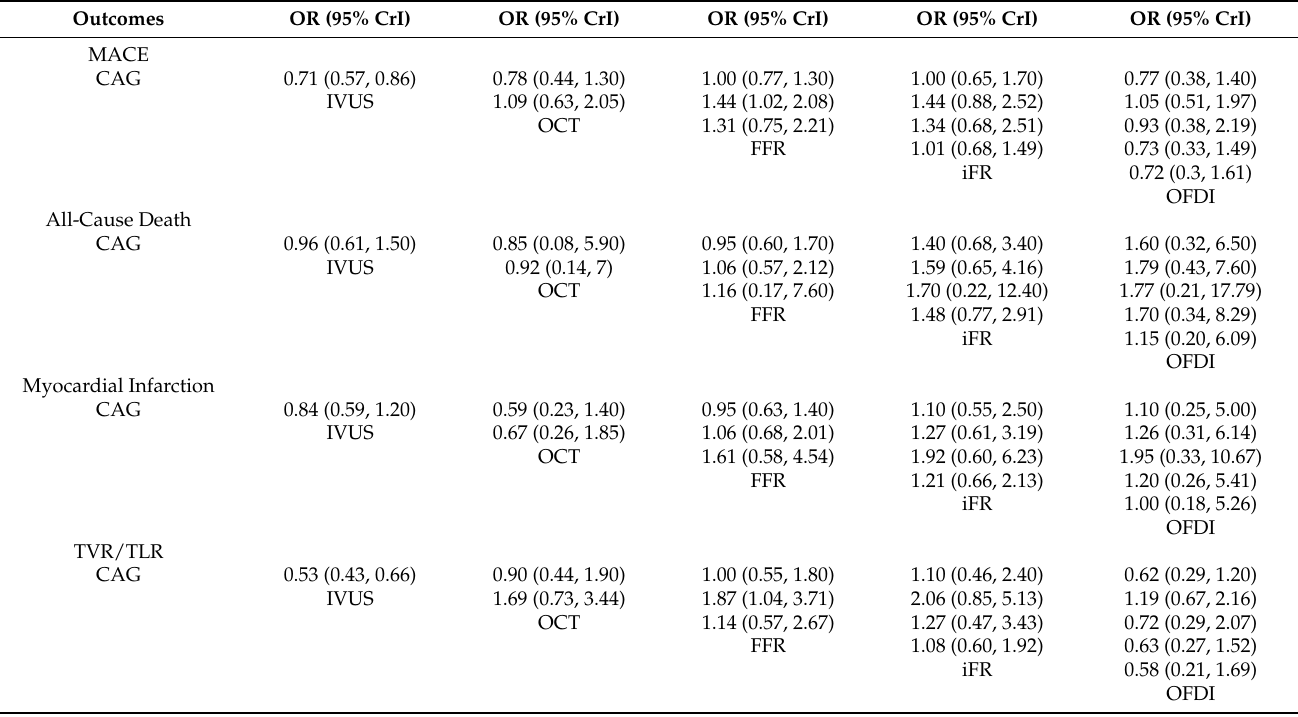
Figure 3. Rank probability analysis for clinical outcomes among guidance modalities in- cluded in the network meta-analysis. CAG: coronary angiography; FFR: fractional flow reserve; iFR: instantaneous wave-free ratio; IVUS: intravascular ultrasound; MACE: major adverse cardiovascular events; OCT: optical coherence tomography; OFDI: optical fre- quency domain imaging; TVR/TLR: target vessel/lesion revascularization. ( A ) MACE; ( B ) All-Cause Death; ( C ) Myocardial Infarction; ( D ) TVR/TLR.